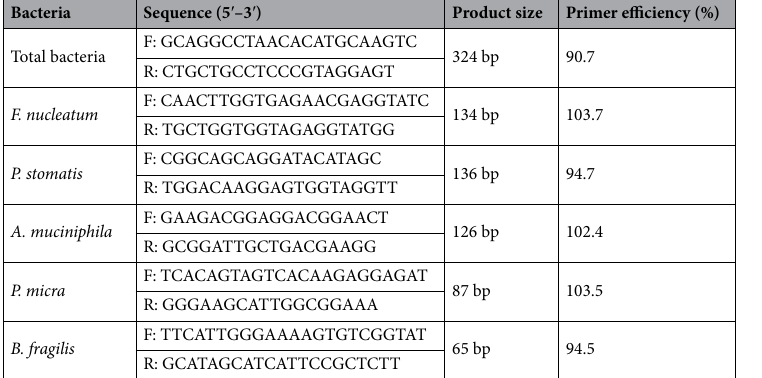
Table 8. List of primers used for qPCR